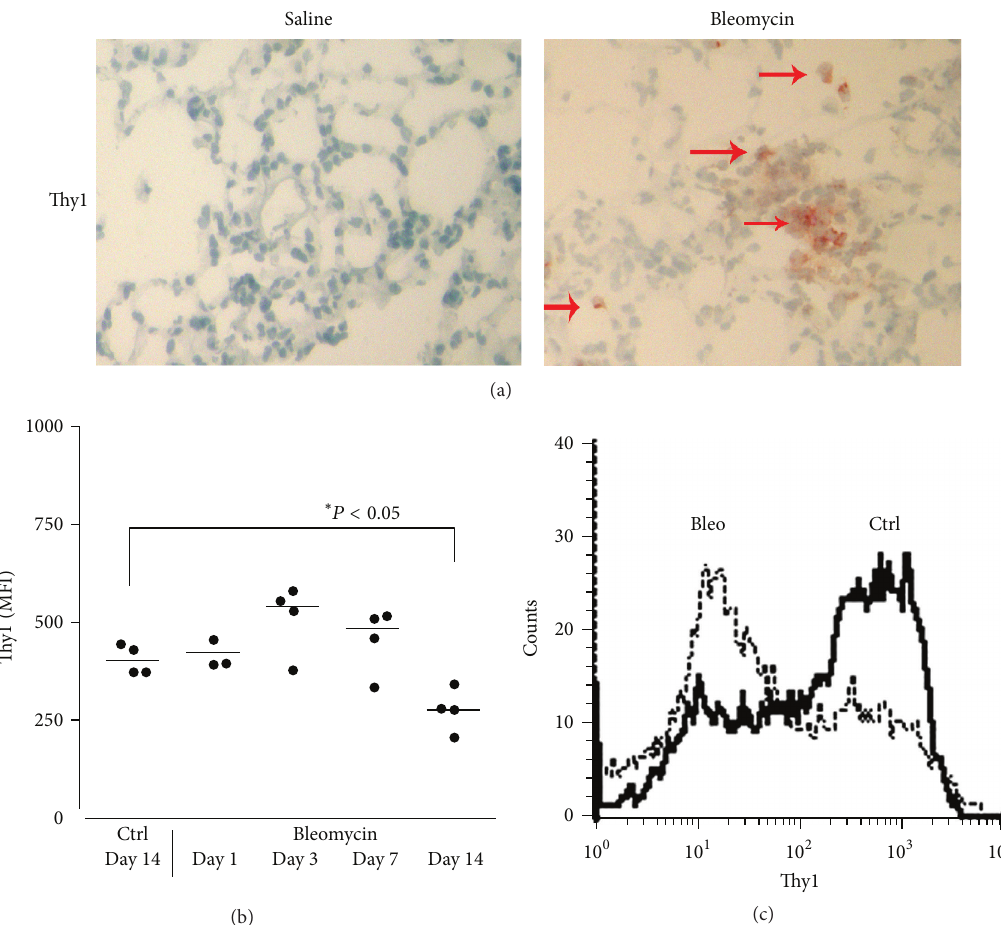
Figure 1: Thy1-positive total lung cells are increased during experimental fibrosis; however, the proportion of myofibroblasts that are Thy1- positive is decreased. (A) Immunohistochemistry of Thy1 staining (arrows), in the lungs of saline- vs. bleomycin-treated mice, 14 days following instillation. Representative results. (B) Lung myofibroblasts were isolated from control saline-treated (Ctrl) and bleomycin-treated mice at 1, 3, 7 and 14 days following IT. A graphical presentation of Thy1 expression FACS analysis was performed using PE-conjugated anti- Thy1 (CD90) mAb. The differences between control (Ctrl) saline-treated and bleomycin-treated mouse lung myofibroblasts on day14 were significant. ∗ 𝑃 < 0.05 , 𝑛 = 4 . (C) Histogram plot showing a representative result of assessment of Thy1 expression in myofibroblasts from control (Ctrl) saline-treated mice compared to Thy1 expression in myofibroblasts from bleomycin-treated mice at day 14 following IT. Results were similar in 2 different experiments ( 𝑛 = 4 ).